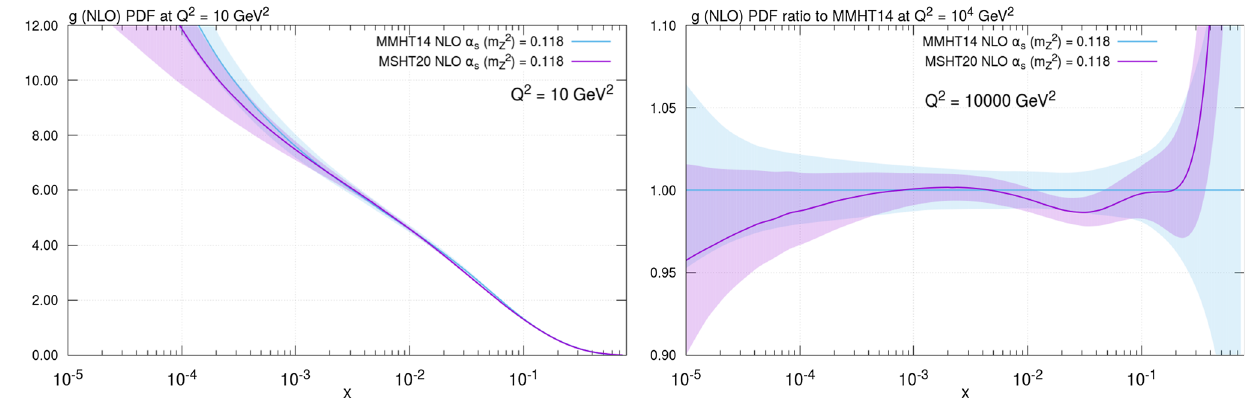
Fig. 31 GluonPDFs,forMSHT20andMMHT14atNLO.(Left)absolutePDFsat Q 2 = 10GeV 2 .(Right)theratiotoMMHT14at Q 2 = 10 4 GeV 2